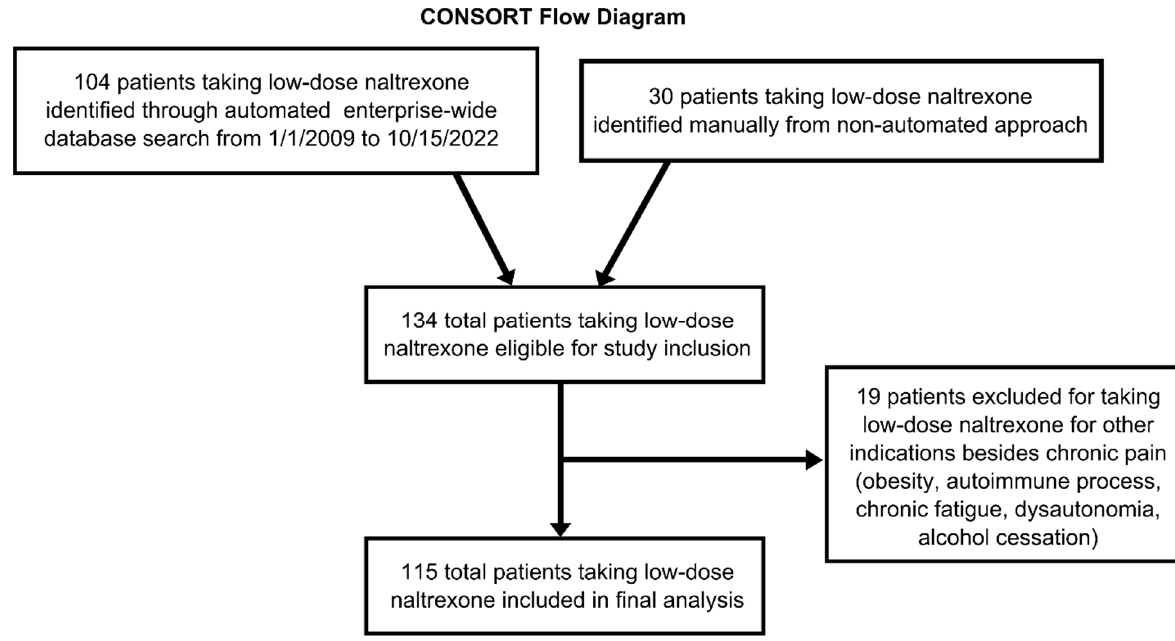
Figure 1. CONSORT Diagram: patient inclusion and exclusion process are displayed.